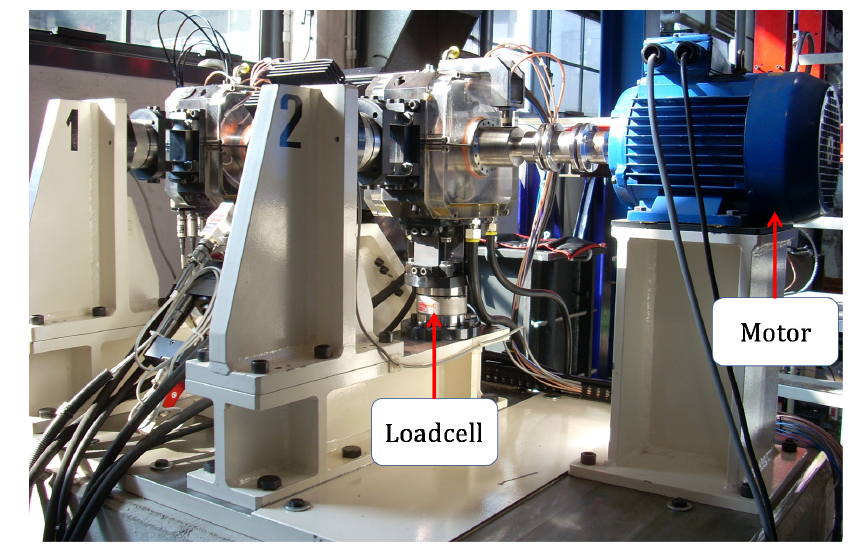
Figure 5. Photo of the test rig.